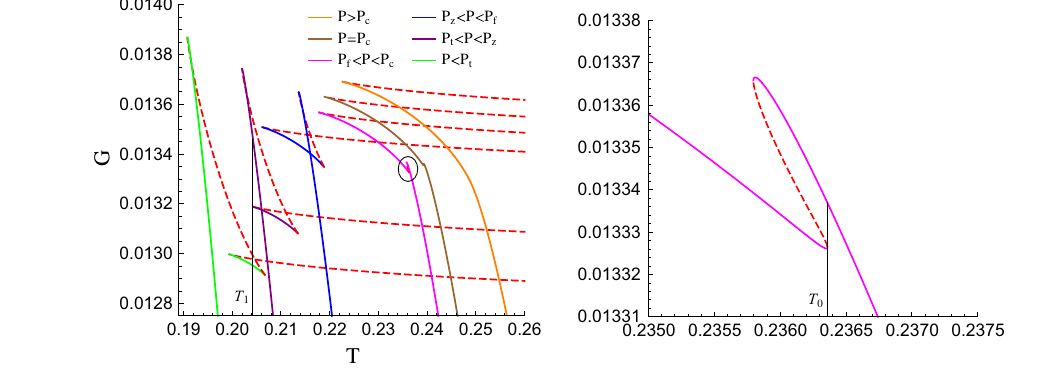
(cid:6) (cid:7) T f , T c )